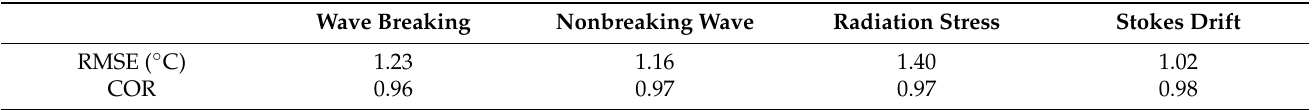
Table 2. Statistical comparisons of sea surface temperatures (SSTs) generated by the sbPOM and Argos during the four typhoons. Wave Breaking Nonbreaking Wave Radiation Stress Stokes Drift RMSE ( ◦ C) 1.23 COR